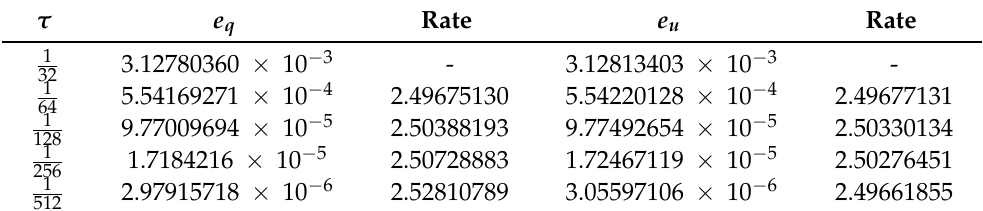
Table 5. Error e q and e u for the time convergence rates with α = 0.5.